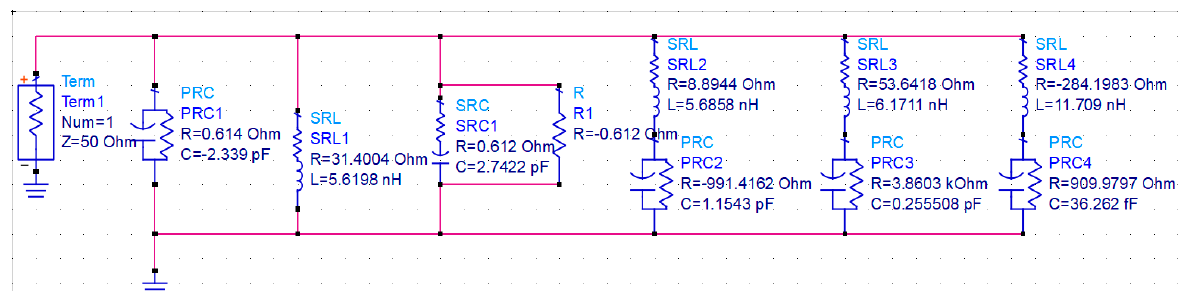
Figure 6. ADS model of the lumped equivalent circuit based on Y data.